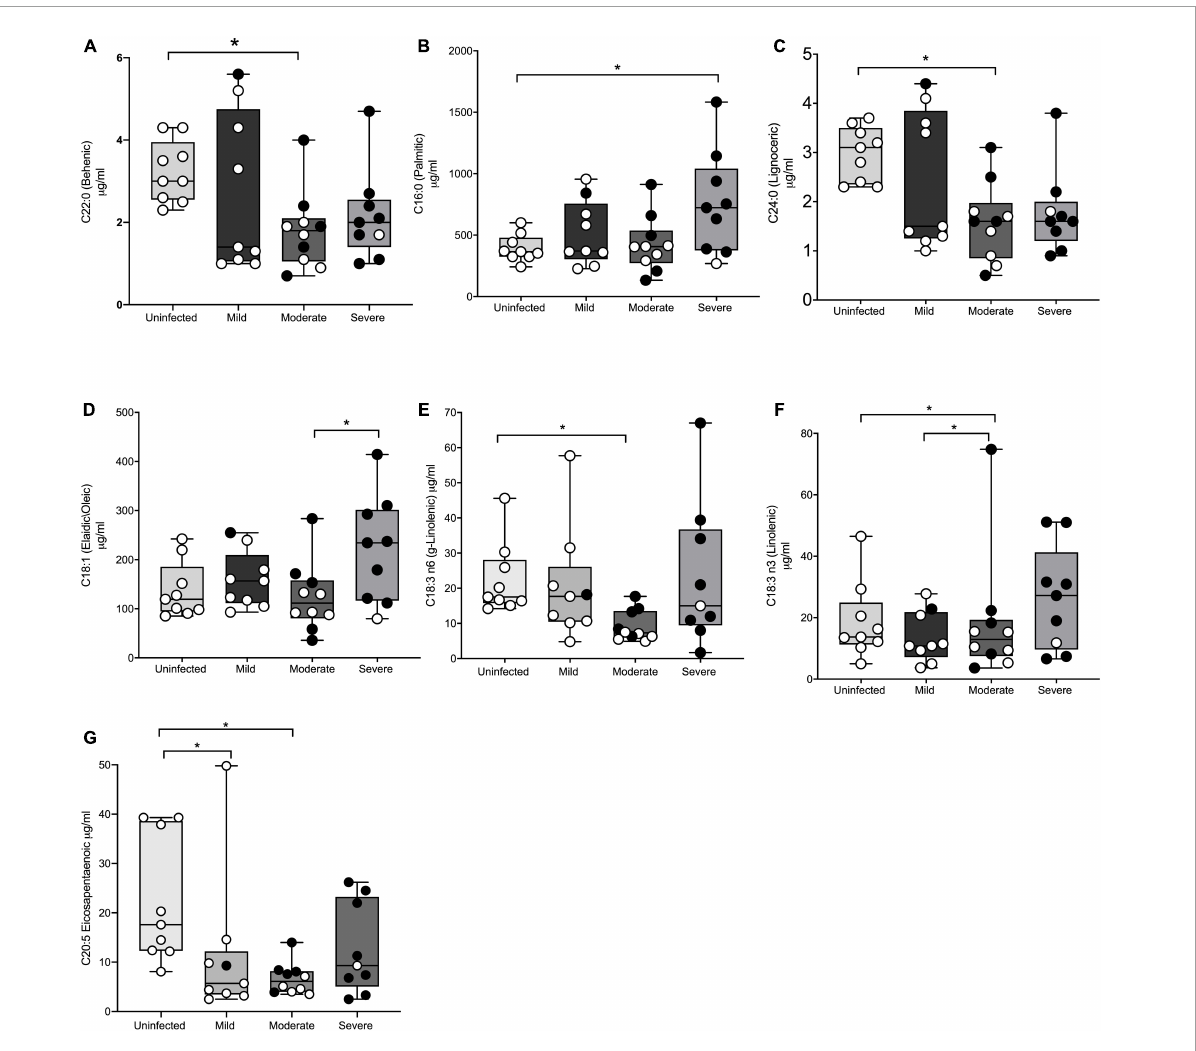
FIGURE1 Significant differences in fatty acid profiles between disease severity groups and the uninfected adults. (A) Behenic acid lower in moderate adults compared to uninfected. (B) Palmitic acid elevated in adults with severe disease compared to uninfected. (C,E) Lignoceric acid and γ -linolenic acid lower in moderate disease compared to uninfected. (D) Oleic acid lower in moderate disease compared to severe disease. (F) Linolenic acid lower in moderate adults compared to mild disease and uninfected. (G) EPA lower in mild and moderate adults compared to uninfected. Shaded points represent adults who received convalescent plasma. * denotes statistical significance p ≤